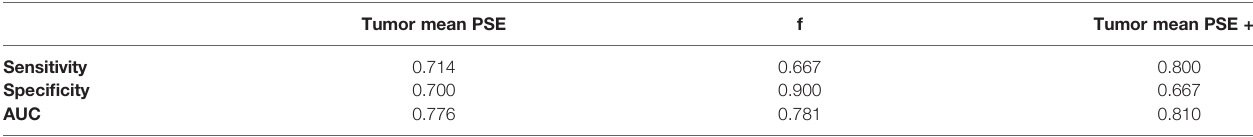
ROC, receiver operating characteristics; OE-MRI, oxygen-enhanced magnetic resonance imaging; IVIM-DWI, intravoxel incoherent motion diffusion-weighted imaging; PSE, percent signal